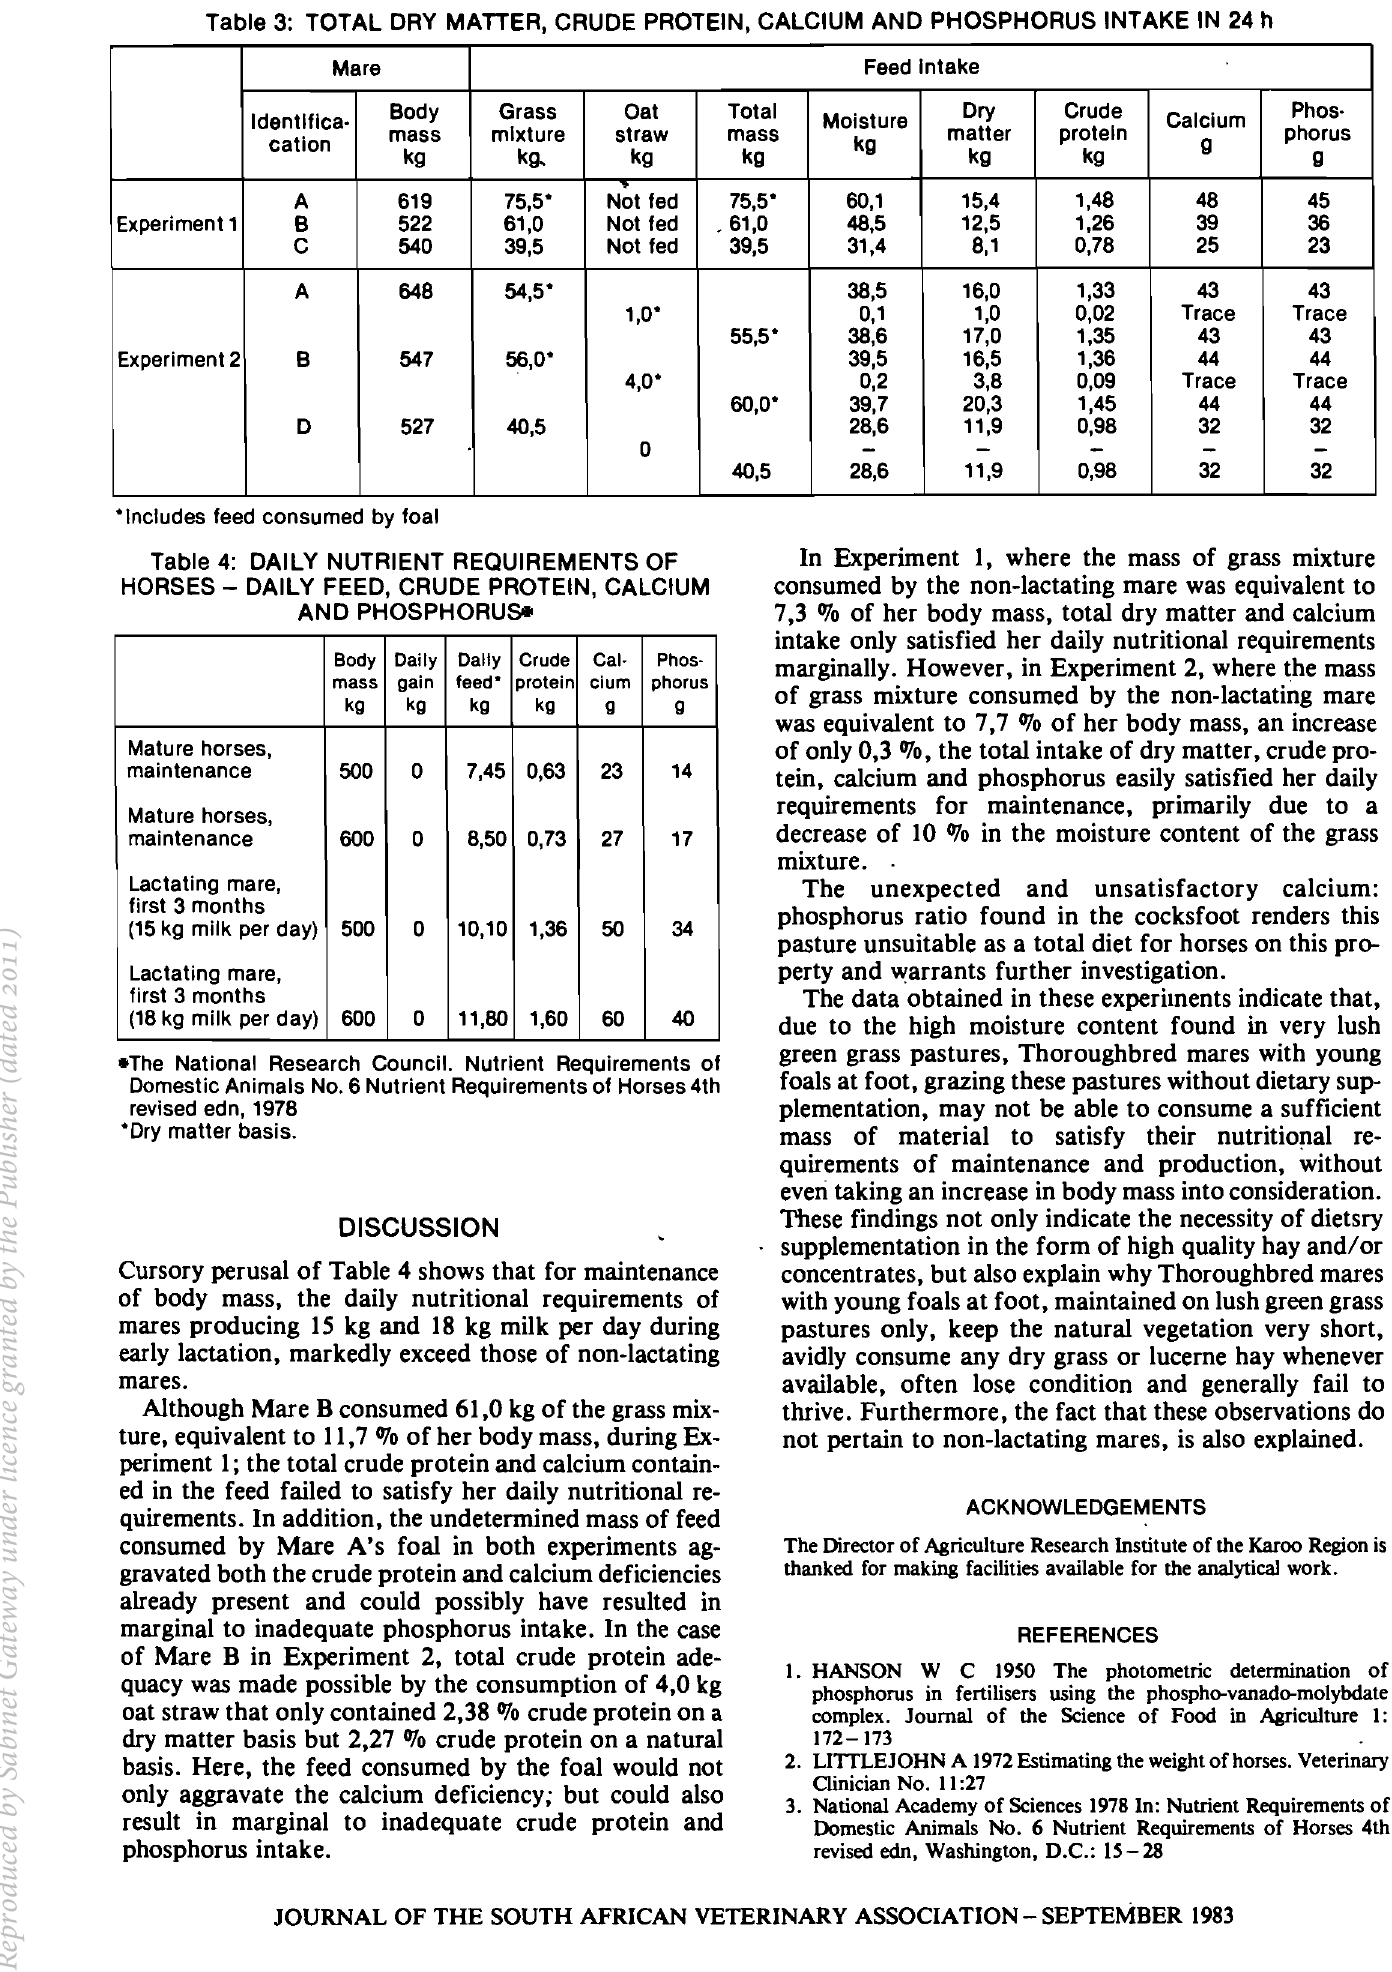
Table 4: DAILY NUTRIENT REQUIREMENTS OF HORSES - DAILY FEED, CRUDE PROTEIN, CALCIUM AND PHOSPHORUS- Body Daily Dally Crude Cal· Phos· mass gain feed" protein cium phorus kg kg kg kg g